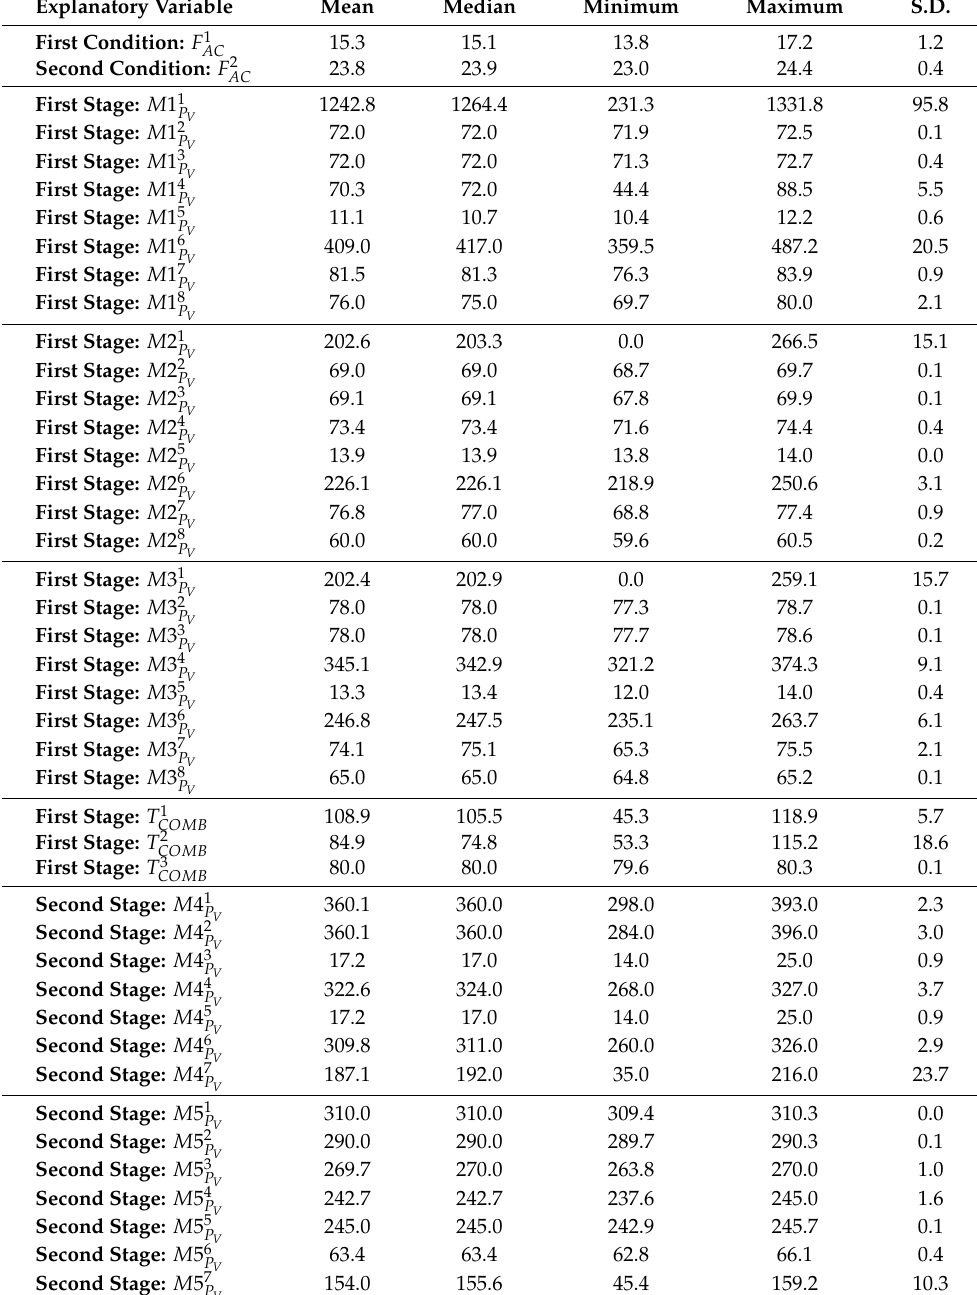
Table 1. Descriptive statistics of the explanatory variables (non-normalized) from the data